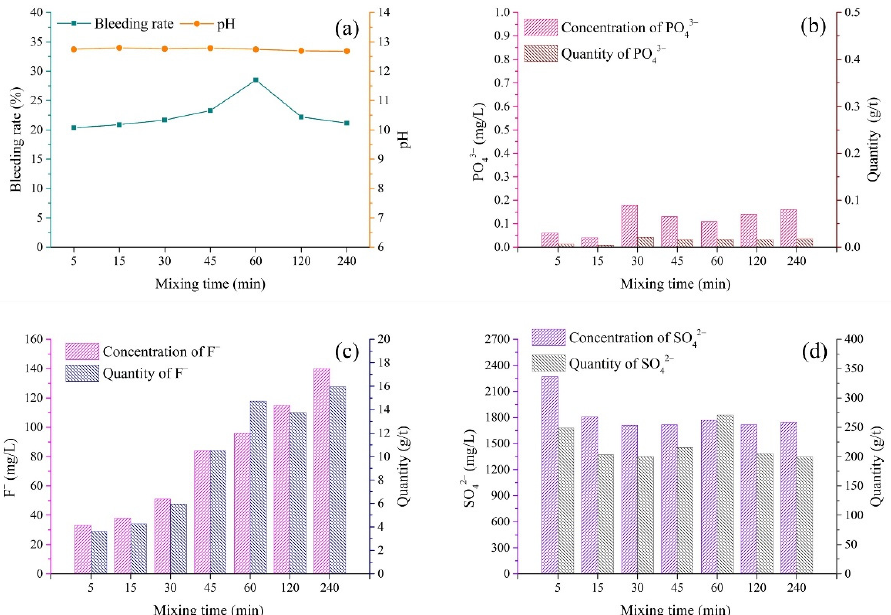
Figure 8. Variations in bleeding rate, pH and pollutants in bleeding water according to mixing time. ( a ) Bleeding rate [37] and pH; ( b ) PO 43 − ; ( c ) F − ; ( d ) SO 42 −